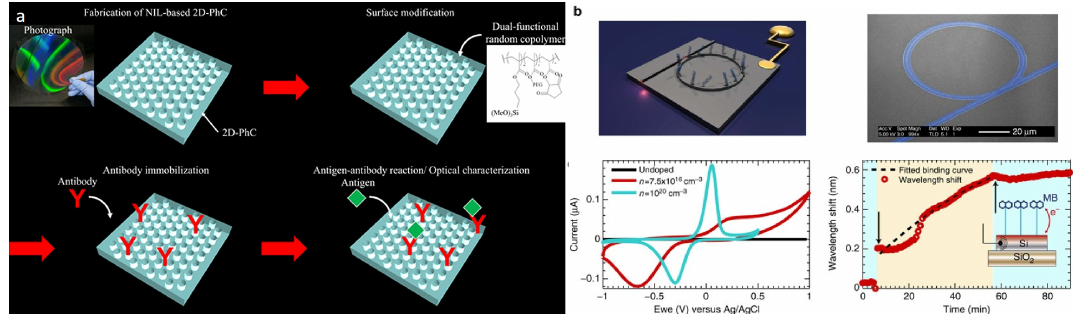
Figure 1. Recently developed sensors for molecular diagnostics. ( a ) Photonic crystal structure based on nanoimprint lithography for immunoassay. ( b ) An electrophotonic sensor that combines electrochemical and photonic characterization. Reprint from